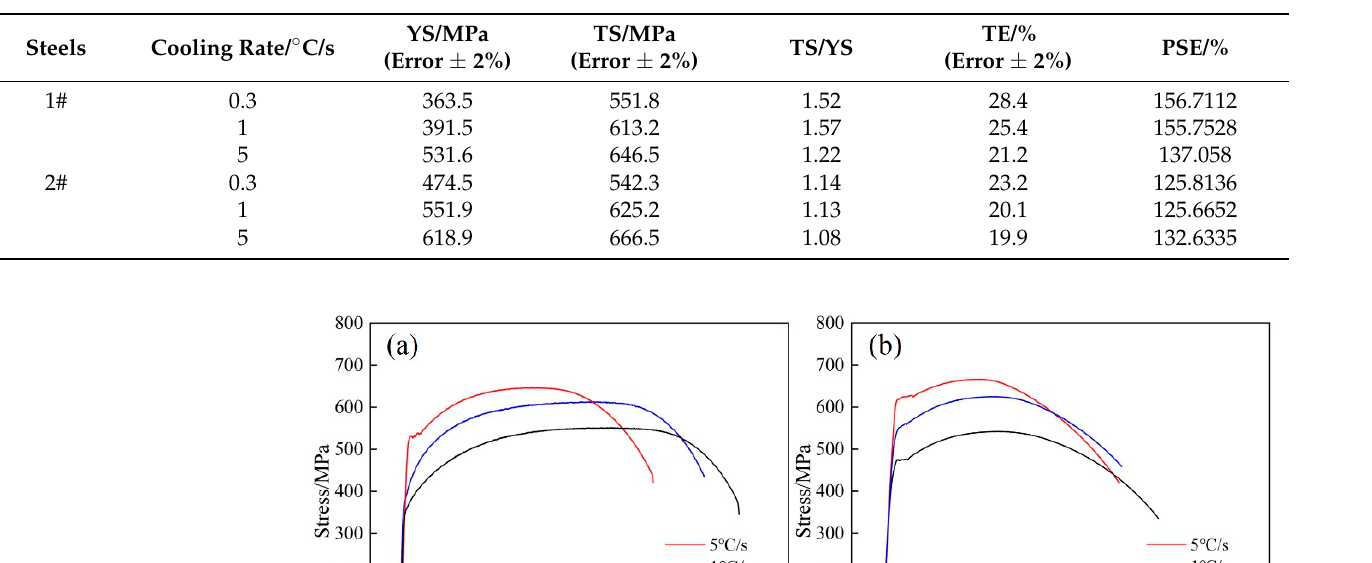
Table 2. Mechanical properties of steels.